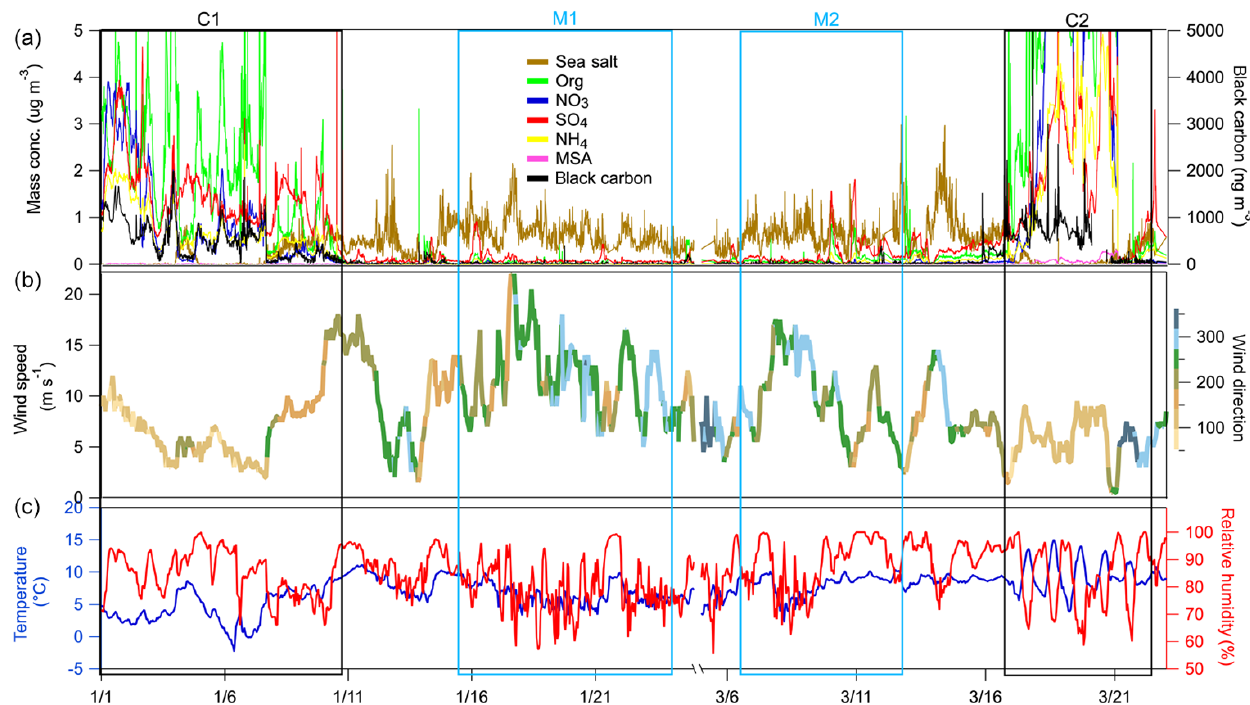
Figure 1. Temporal variation of (a) the mass concentration of chemical species measured by the HR-ToF-AMS and MAAP; (b) wind speed (ms − 1 ) with wind direction represented using a colour scale; ( c ) and temperature ( ◦ C; blue line) and RH (hPa; red line). The boxed areas correspond to the continental events (C1 and C2; black) and the marine events (M1 and M2; blue).